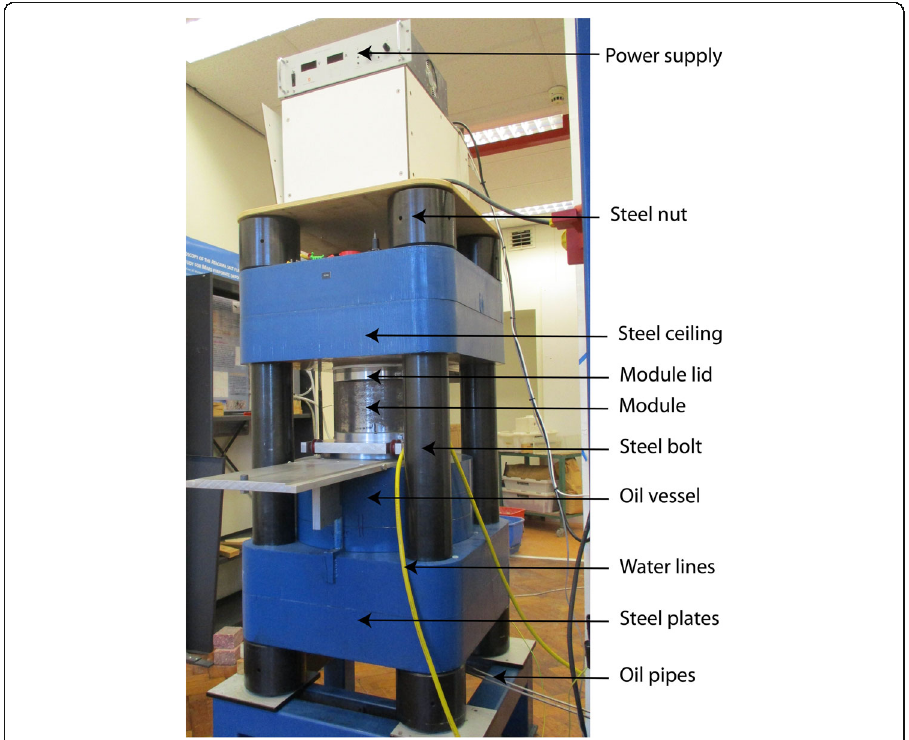
Fig. 1 The multi-anvil apparatus at Vrije Universiteit Amsterdam